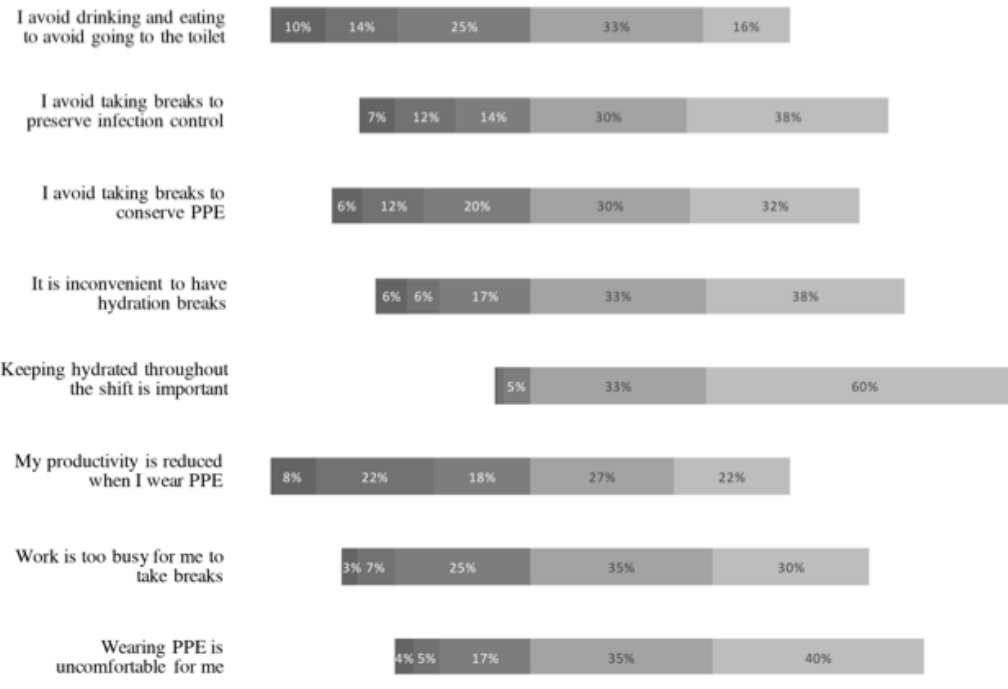
Figure 2. HCW respondents’ responses (total) to statements on attitudes towards personal protective equipment (PPE) usage on a 5-point Likert scale: (1) strongly disagree; (2) disagree; (3) neither agree nor disagree; (4) agree; (5) strongly agree.